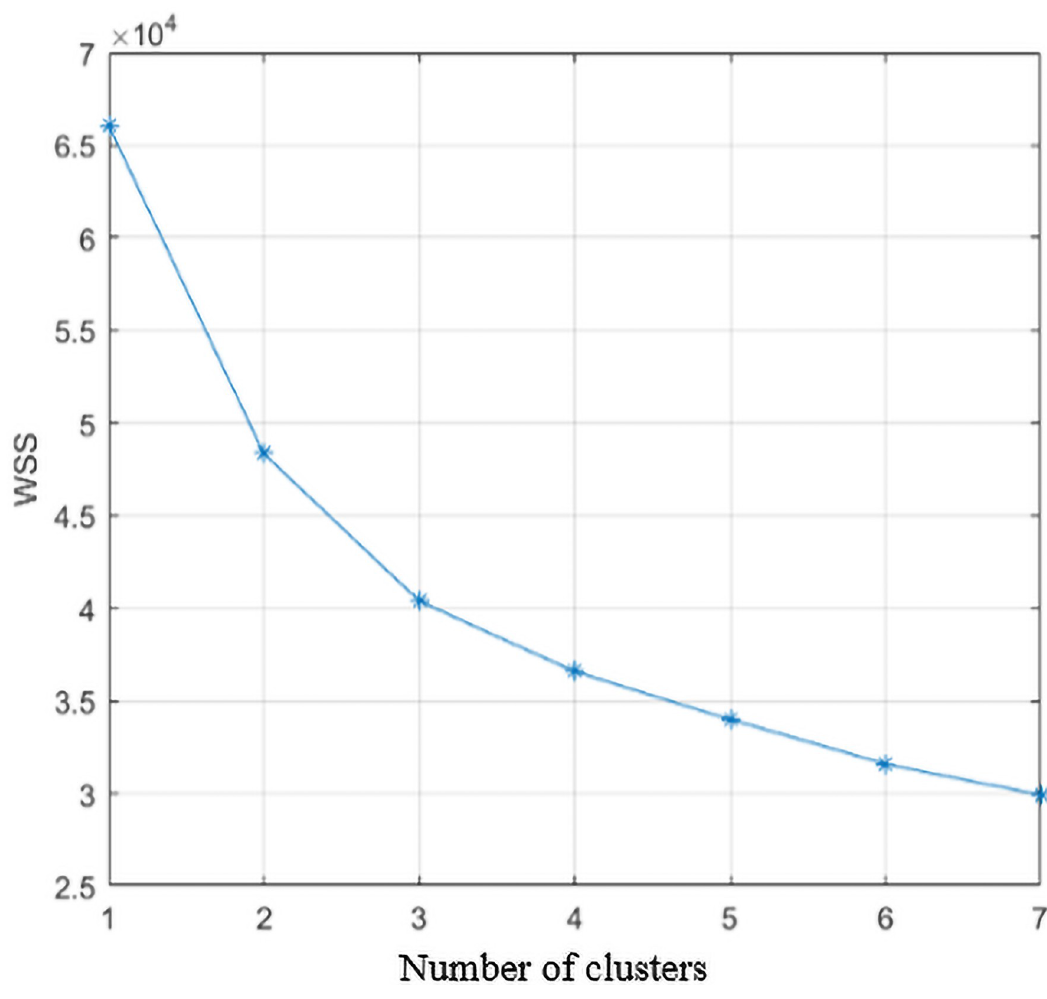
Fig 4. Relationship between cluster number and